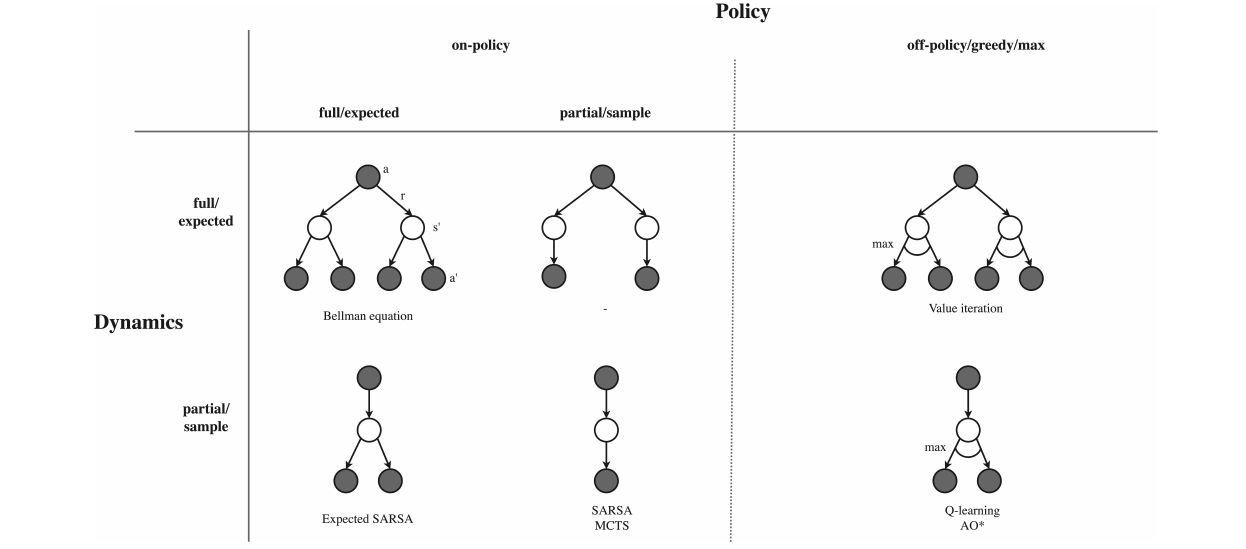
FIGURE 7 | Types of 1-step back-ups. For the back-up over the policy (columns), we need to decide on i) the type of policy (on-policy or off-policy) and ii) whether we do a full or partial back-up. For the back-up over the dynamics (rows), we also need to decide whether we do a full or partial back-up. Note that for the greedy/max back-up policy the expected and sample back-ups are equivalent. Mentioned algorithms: Value Iteration ( Bellman, 1966), Expected SARSA (Van Seijen et al., 2009), SARSA (Rummery and Niranjan, 1994), MCTS (Kocsis and Szepesvári, 2006), Q-learning (Watkins and Dayan, 1992), and AO ⋆ (Nilsson, 1971).